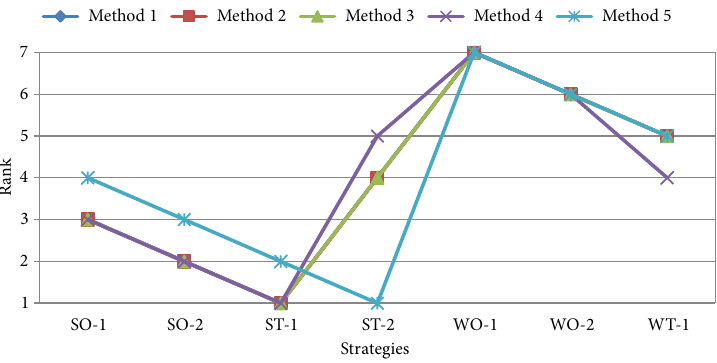
Fig. 7. Comparison of different solution